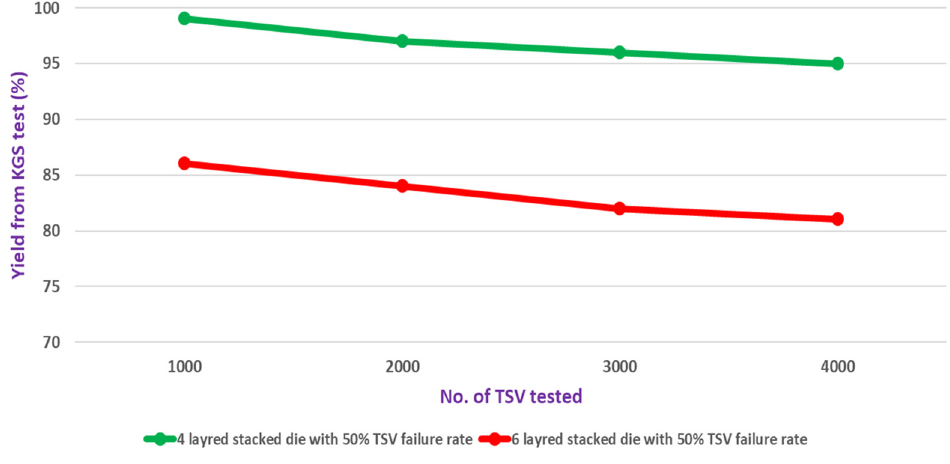
Figure 2. Statistical analysis data of yield impact w.r.t. variable faulty TSVs.